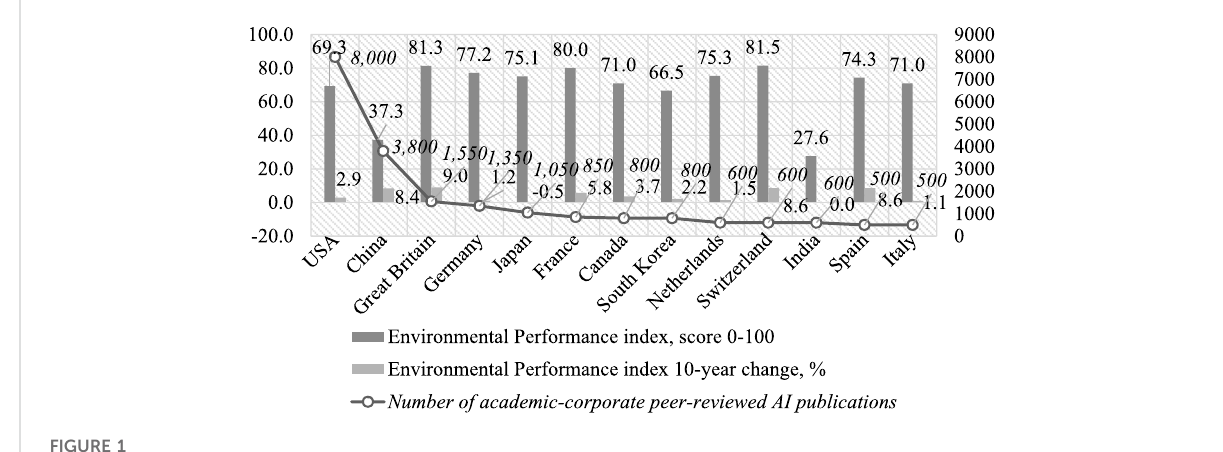
FIGURE 1 TheEnvironmentalPerformanceIndexin2020,itsten-yeartrend,andthenumberofeducationalandcorporatepeer-reviewedAIpublications in 2021. Source: OECD AI Policy observatory (2022), Yale Center for Environmental Law and Policy, Center for International Earth Science Information Network, The McCall MacBain Foundation